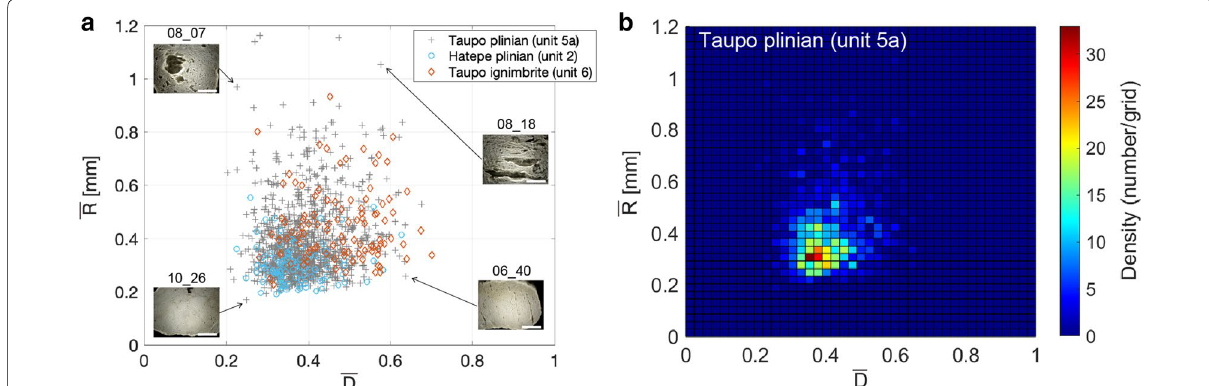
Fig. 8 Heterogeneous bubble textures. a Plot of the average bubble radius R against the average bubble deformation degree D for all measured clasts from the 232 AD Taupo eruption. Inset images show the cross sections of the representative samples shown in Figs. 4, 5, 6 and Table 2. b The number density of crosses in a shown by